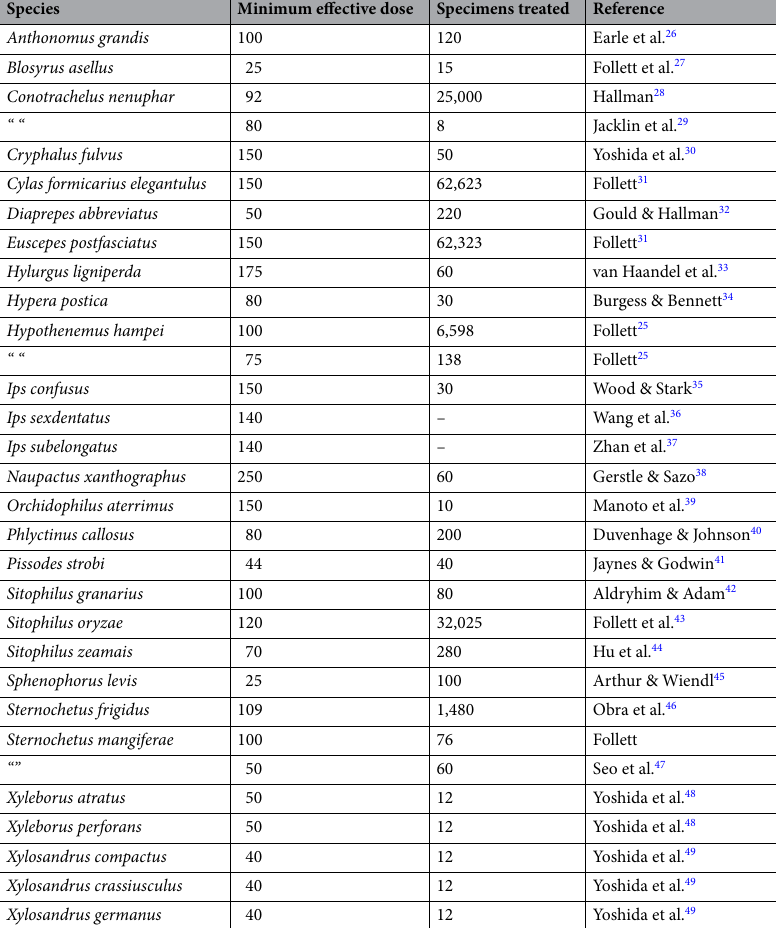
Table 1. Efficacious doses from Curculionidae literature review.